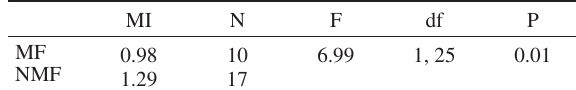
values. Table 3. – Analysis of covariance to compare moult increments (MI) between females that showed no mature gonads (NMF) and fe- males that later showed mature gonads (MF). MI, adjusted mean of RI; N, number of individuals; F, statistic F; df, degrees of freedom; P, probability; Significance level (P<0.05)